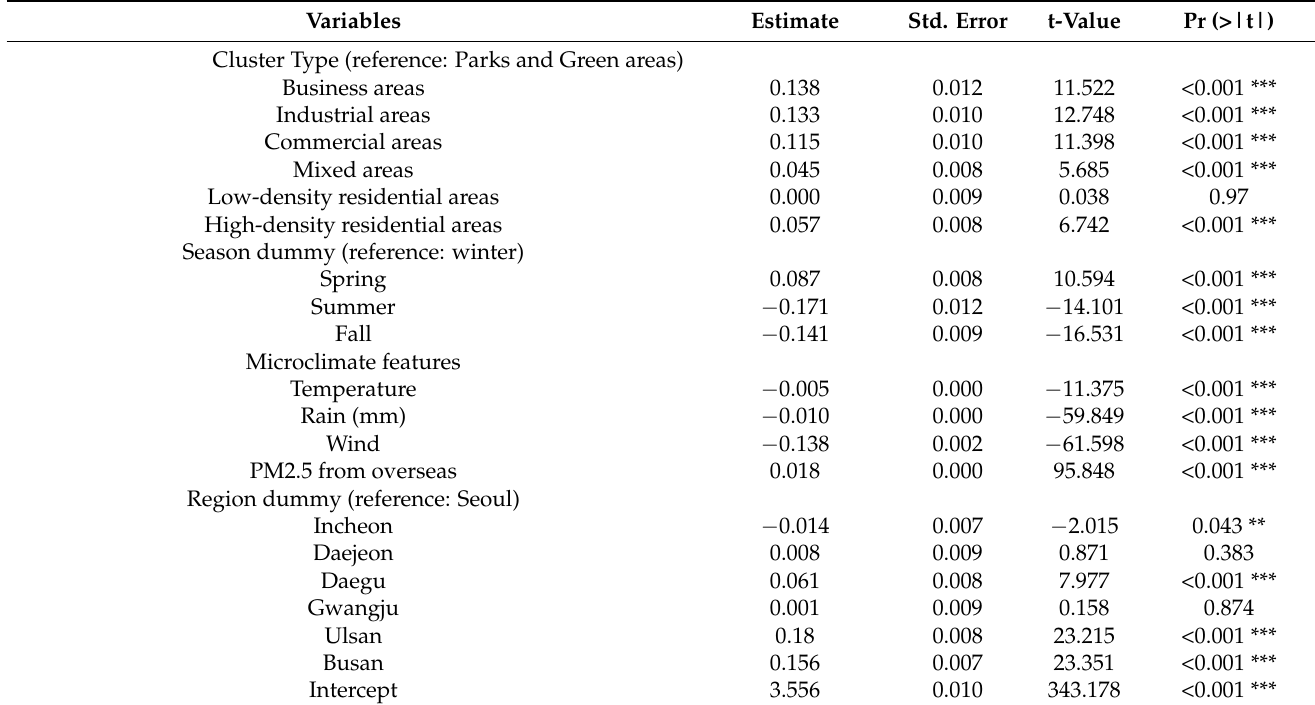
Table 6. Log-Lin Regression Model on Average Daily PM10